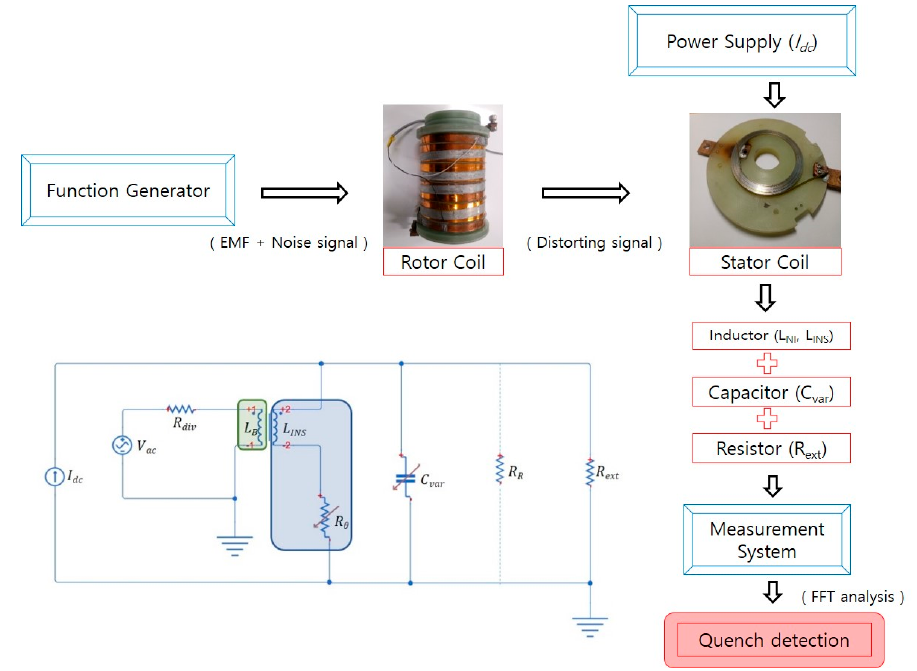
function: ( a ) INS coil and ( b ) NI coil.